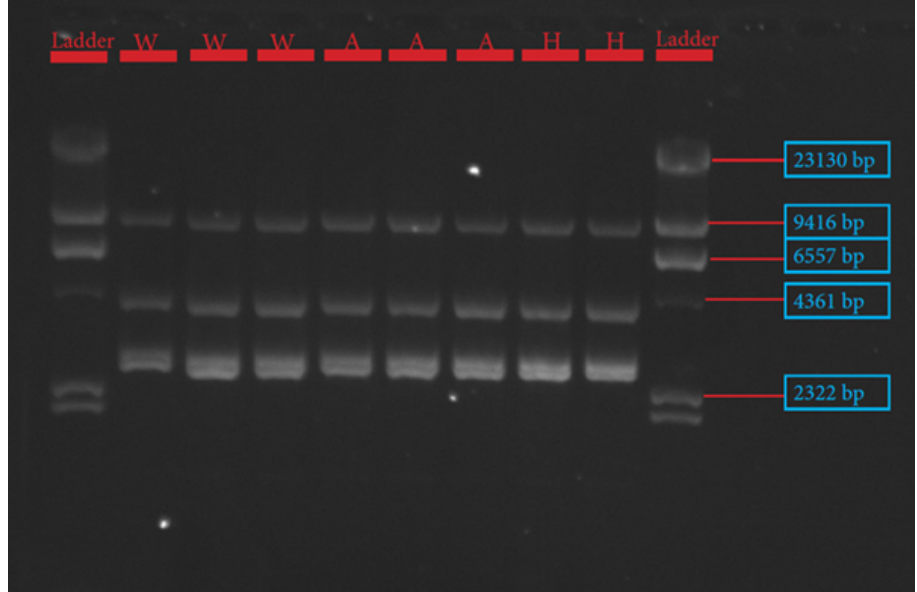
Figure 1. Gel image of stearoyl Co ‐ A desaturase (SCD) gene fragments 1–4.